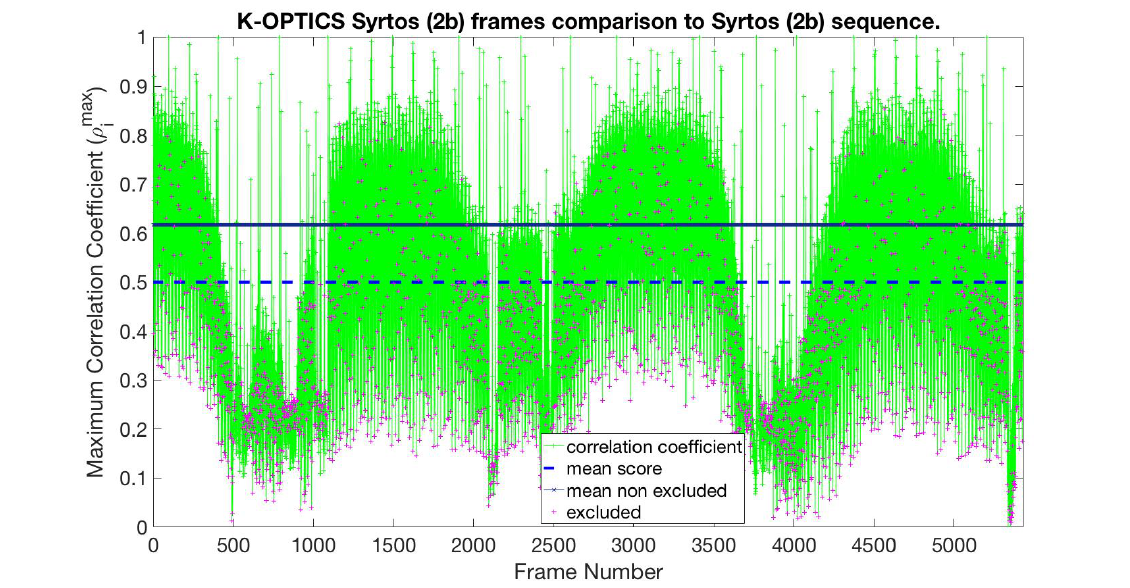
Figure 8. The maximum correlation scores ρ max sequence compared to the summarized one using K-OPTICS.